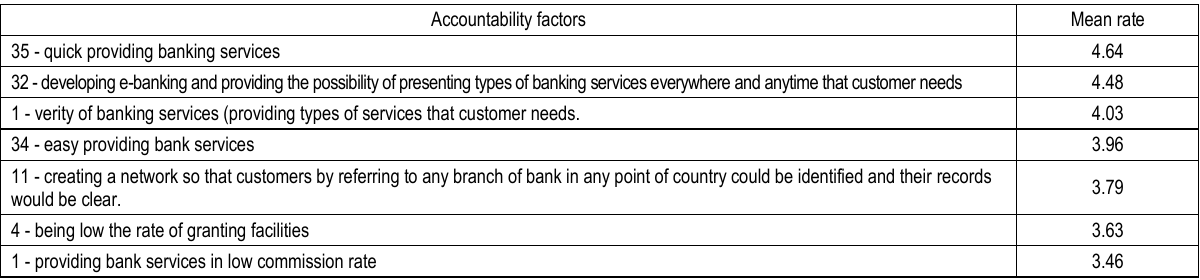
Table 11. Results of average of physical necessities factors based on